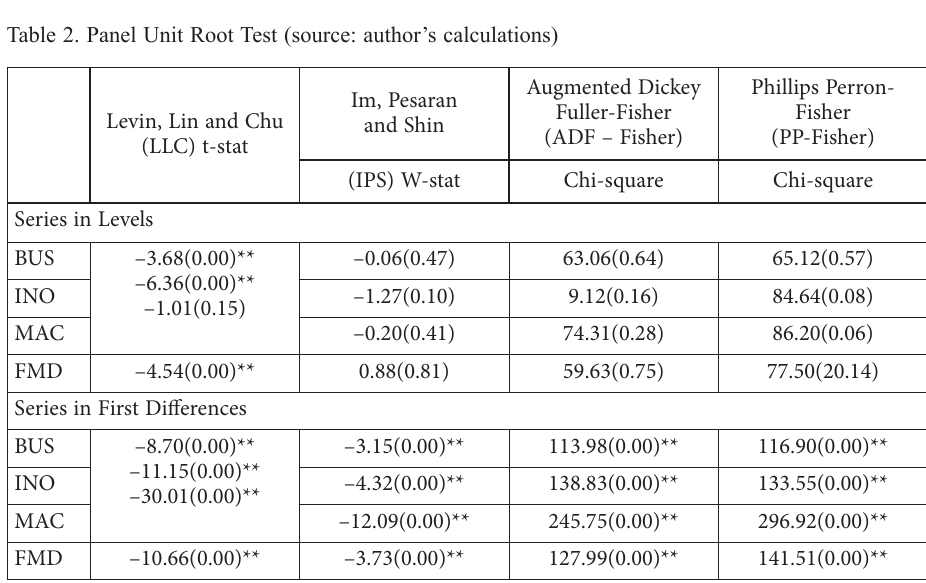
Phillips Perron- Fisher (PP-Fisher)